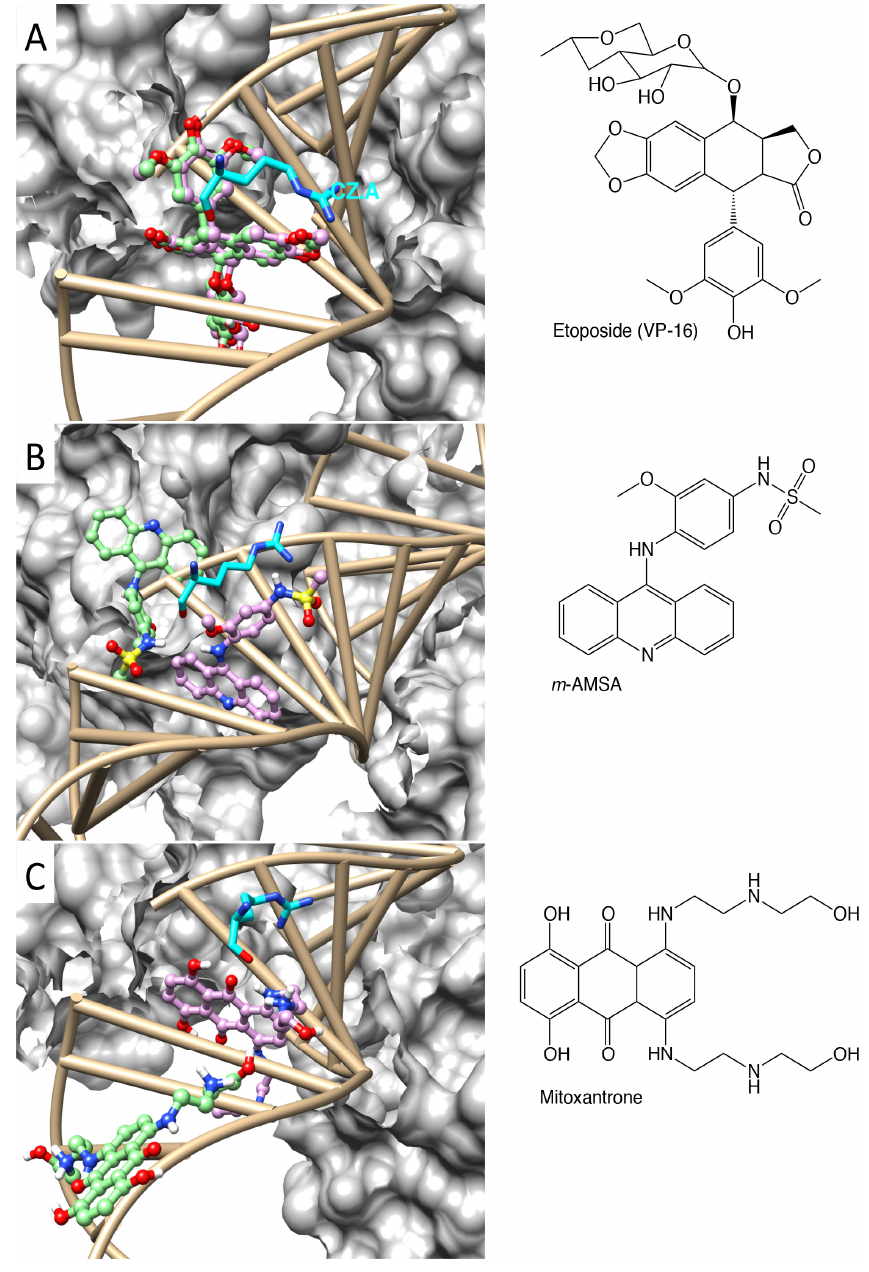
Figure 1. Crystallographic binding modes (pink) and docking poses (green) of VP-16 ( A ); m -AMSA ( B ); and mitoxantrone ( C ) in the cleavage complex of TOP2- β . The R503 in proximity to the ligands (cyan), the double-stranded DNA and the surface of one monomer of the dimerized proteins are